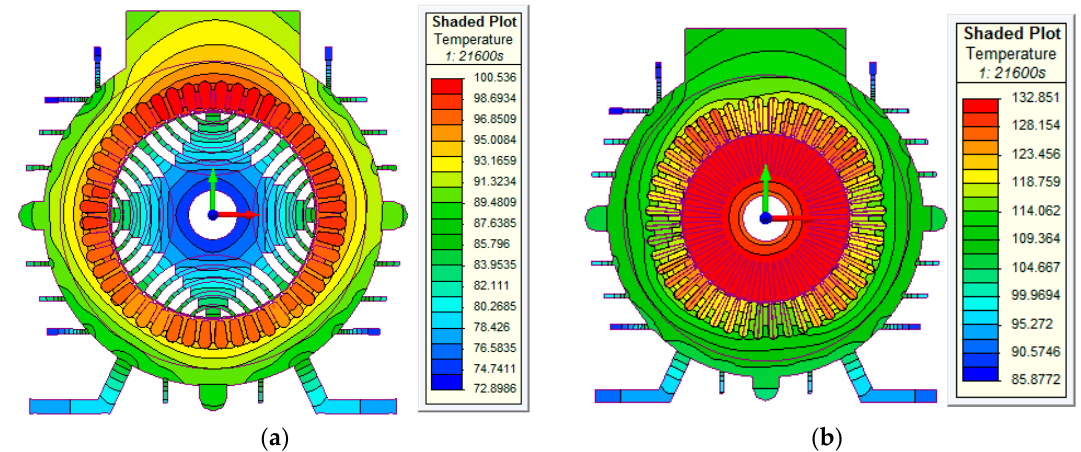
Figure 11. Temperature distribution for ( a ) G2 and ( b ) G3 ( + 30 ◦ C ambient temperature). * All units are in ◦ C